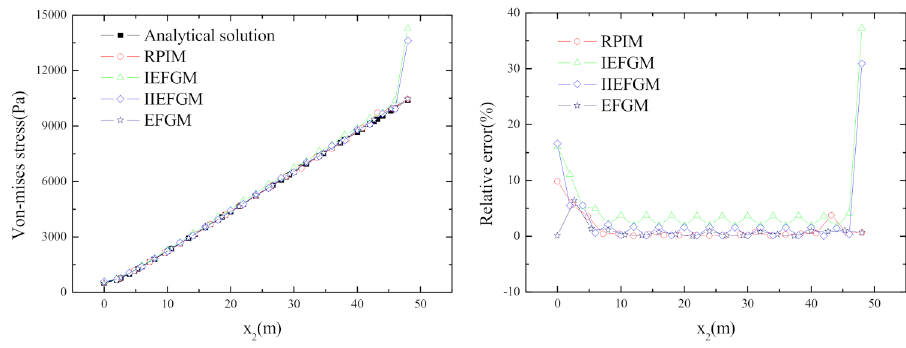
Figure 7. Solutions of the Von Mises stress and the relative error at x 2 = 0.